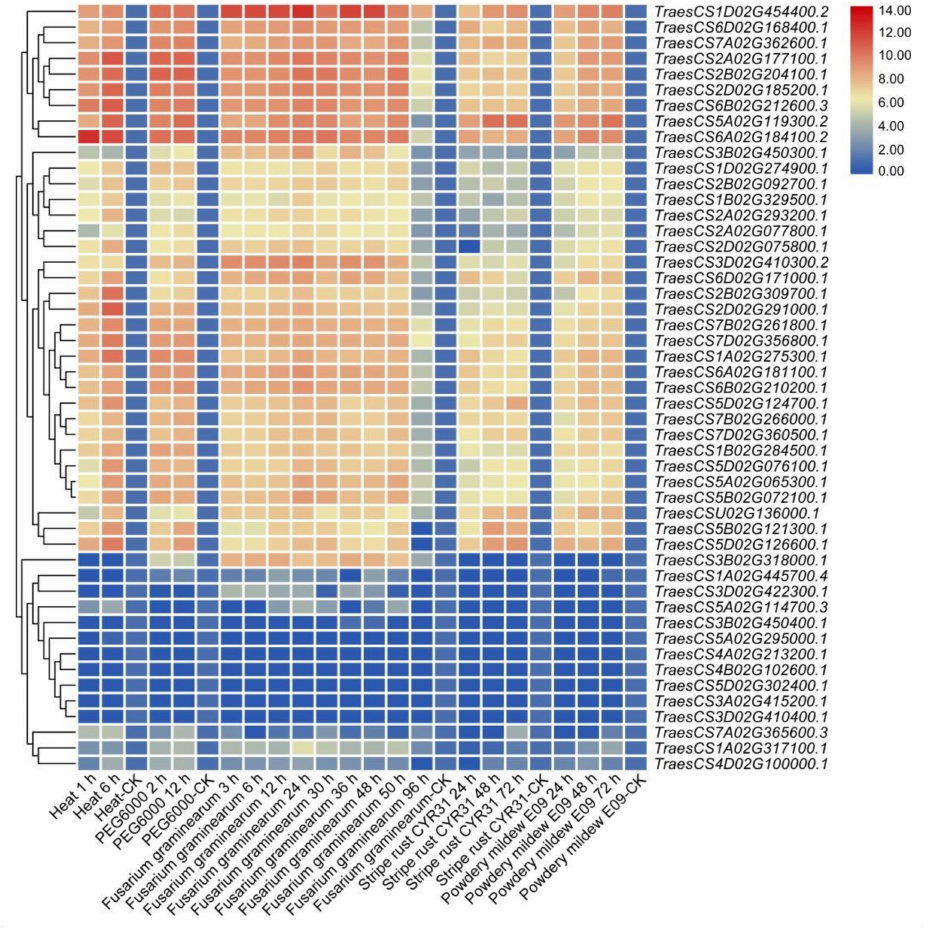
Figure 6. The expression profiles of the TaHDAC gene family in Triticum aestivum under abiotic or biotic stresses. The heatmaps were constructed by TBtools based on the expression datasets. Expression levels were represented in diverse colors, with red indicating higher expression levels and blue indicating lower expression